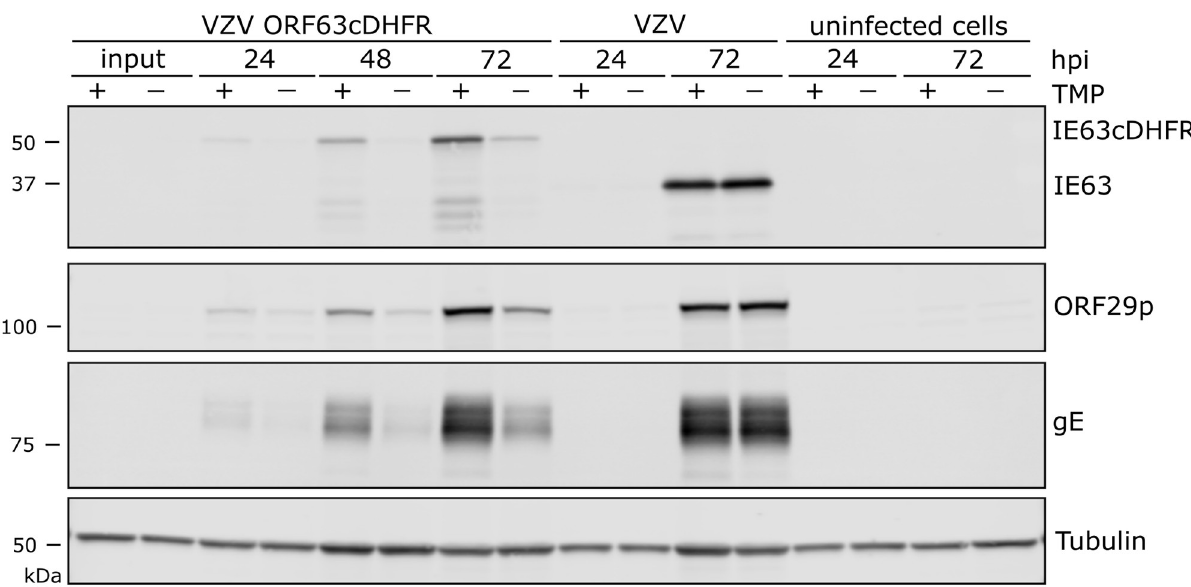
Fig 5. VZV IE63 is regulated by DHFR degron domain fused to carboxy-terminus. Proteins were analyzed similarly to that shown in Figs 3 and 4. Protein samples were of cells infected with VZV ORF63cDHFR, pOka, or uninfected cell equivalents up to 72-hpi. Wild-type ORF63 (IE63) and DHFR modified (IE63cDHFRp) protein, proteins from alternative kinetic classes (ORF29p, gE), or cellular control (alpha-tubulin) were compared under TMP permissive (+) and nonpermissive (-) conditions. The blots are scanned in linear range and representative of two identical experiments.